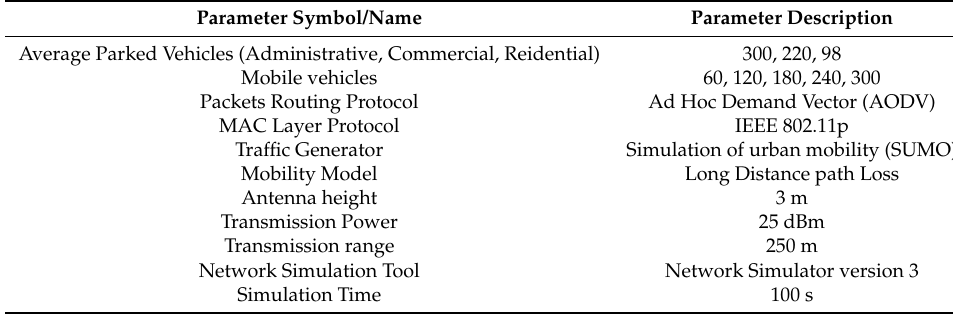
Table 2. Simulation Parameters for Network Performance